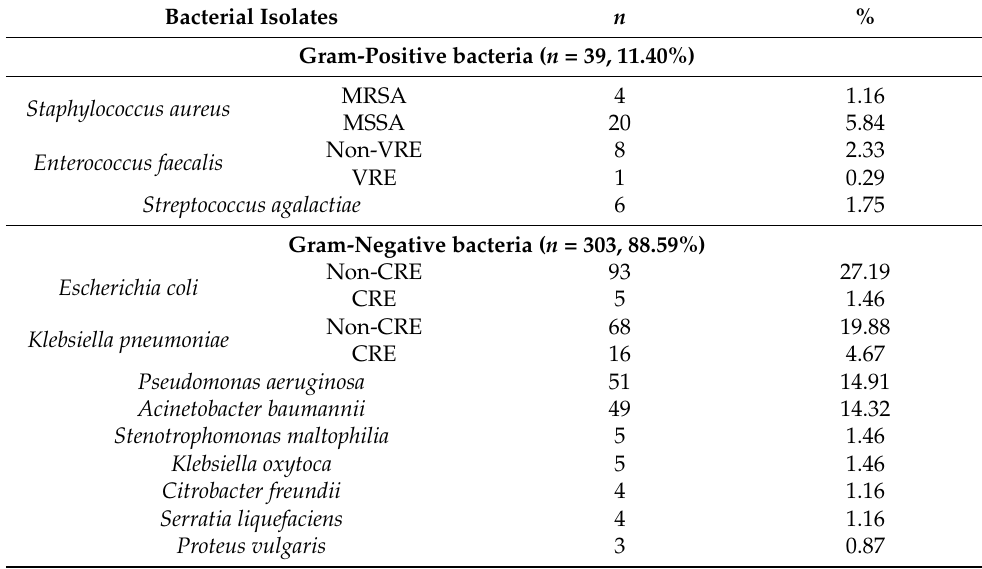
Table 2. The general prevalence of bacterial co-infections in COVID-19 patients admitted in ICU.